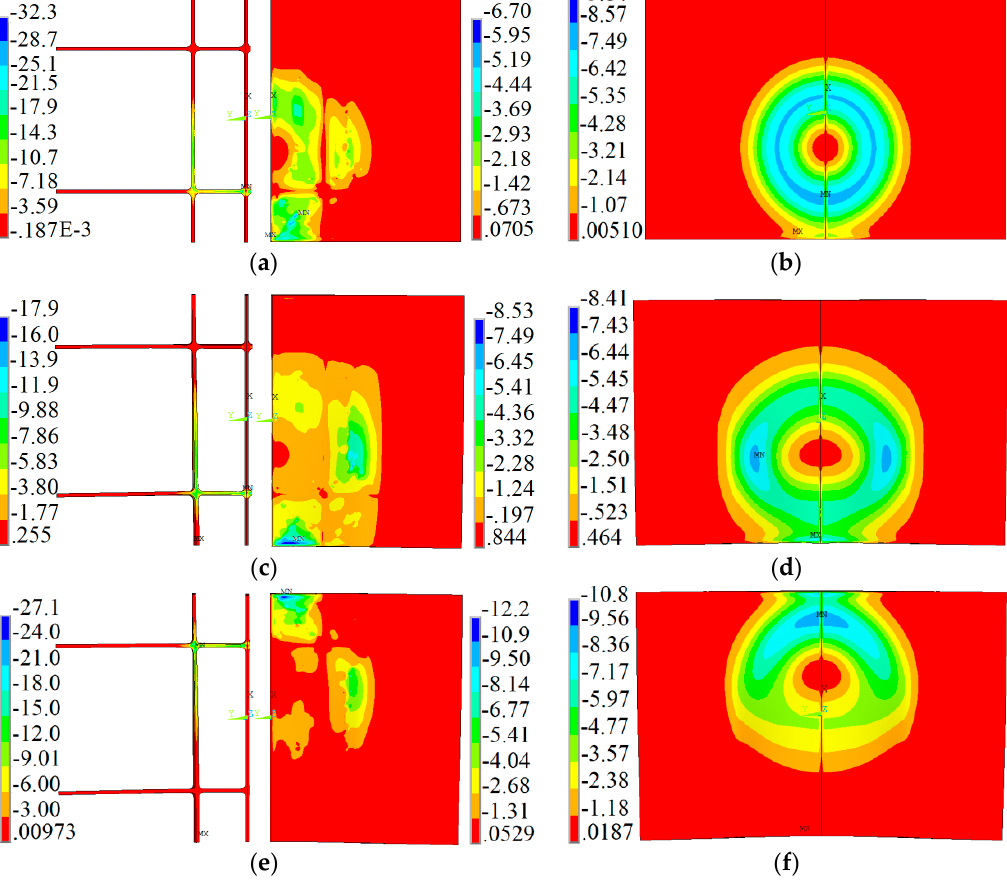
EMF in the first discharge ( a , b ), second discharge ( c , d ) and third discharge ( e , f ).